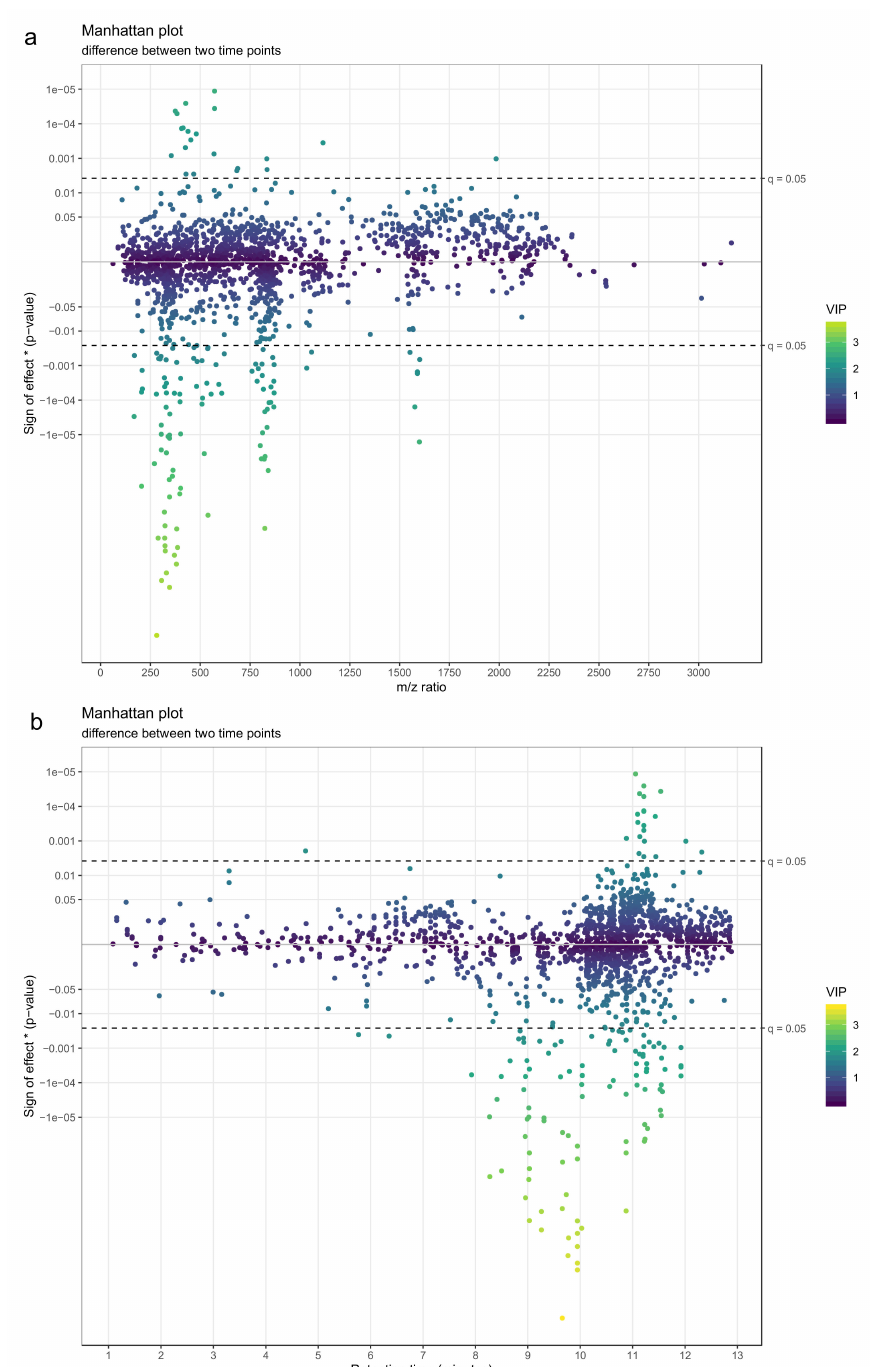
Figure 23. ( a ) A directed Manhattan plot of p -values from linear models testing the di ff erence of feature abundances between two time points with mass-to-charge ratio of the features as x-axis. The points are colored by variable importance in projection (VIP)-value from a partial least squares-discriminant analysis (PLS-DA) model trained to separate the two time points. The most interesting groups of molecular features seem to have m / z ratios around 350 and around 800. Both groups are predominantly lower in the end of the intervention. ( b ) A similar directed Manhattan plot, only with retention time of the features as y-axis. The most interesting groups of molecular features seem to have retention times around 9–10 min and around 11 min. The first group is predominantly lower in the end of the intervention, while the features in the second group have mixed